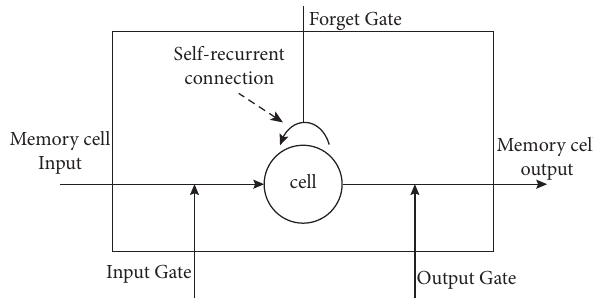
Figure 2: Internal structures of neurons in recurrent neural